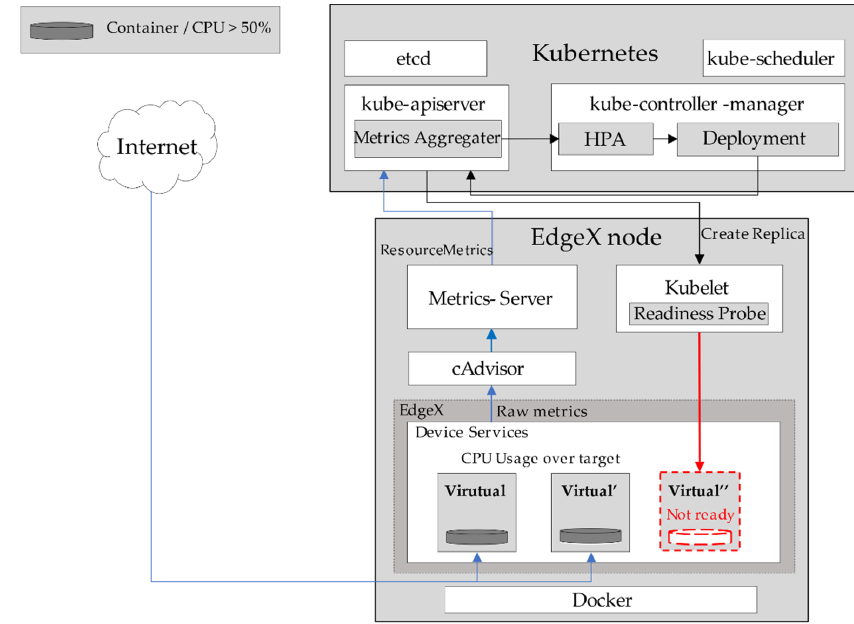
Figure 4. HPA architecture of